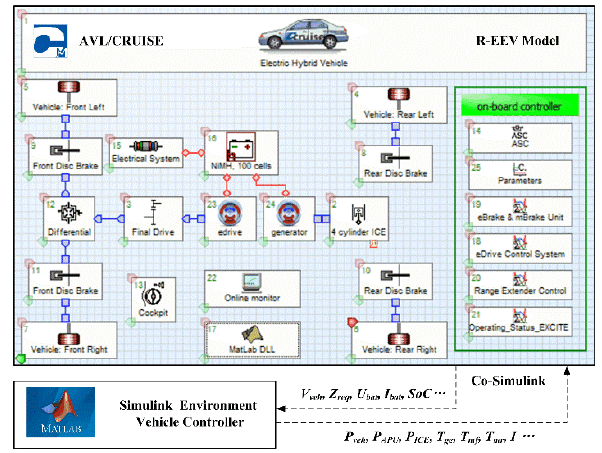
Figure 8. Simulation platform of the R-EEV for the MOO problem.